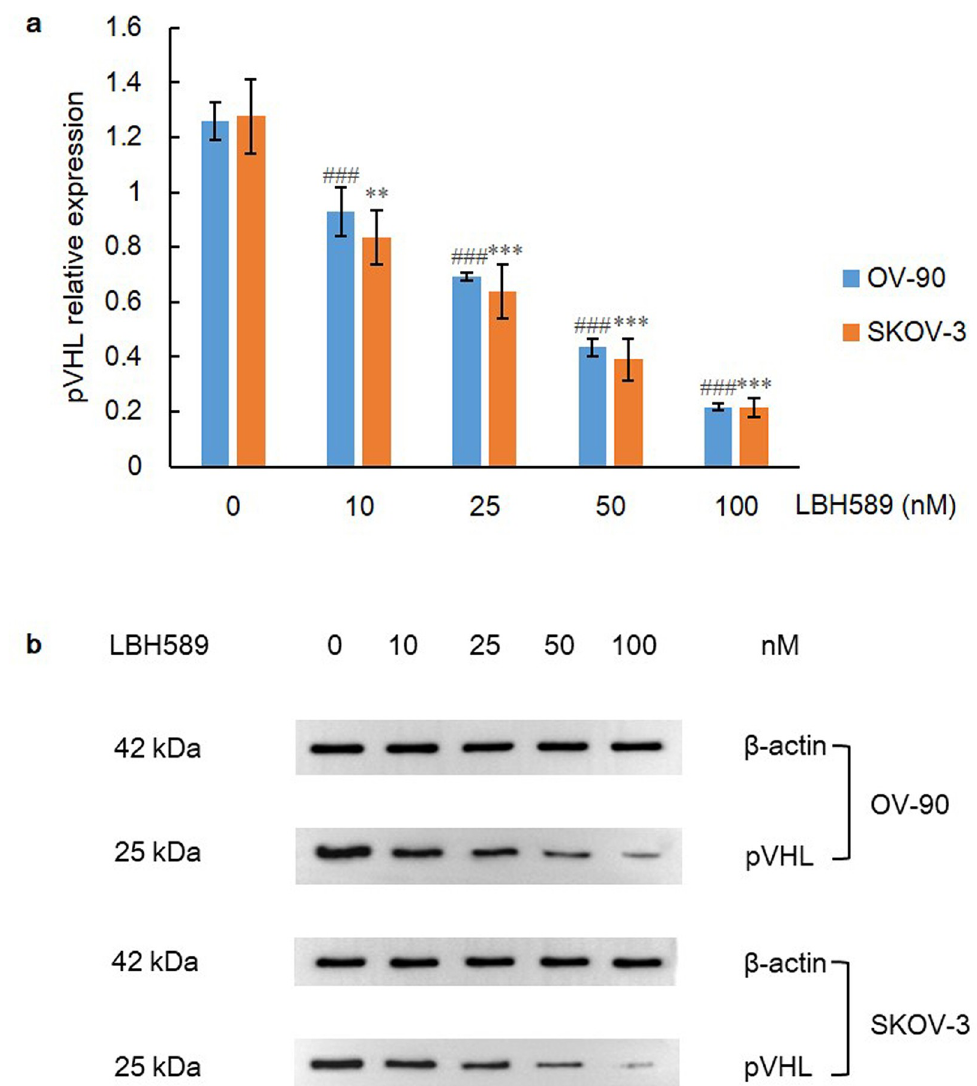
Fig 5. pVHL expression after LBH589 treatment for 48 h. A) LBH589 inhibits expression of pVHL in OV-90 and SKOV-3 cell lines. Data are shown as mean ± SD of at least three individual experiments. ( � P < 0.05, �� P < 0.01, ��� P < 0.001 vs. SKOV-3 control (0.1% DMSO); # P < 0.05, ## P < 0.01, ### P < 0.001 vs. OV-90 control (0.1% DMSO)). B) The expression of pVHL was assessed by western blot analysis after LBH589 treatment for 48 h. The equal protein loading is shown by detection of β -actin. The figures show representative blots which were cropped from original images.